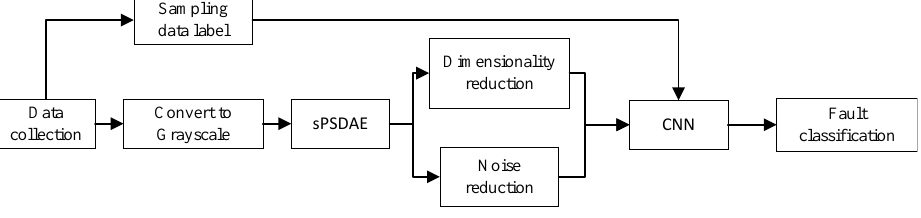
Figure 6. sPSDAE-CNN algorithm model.